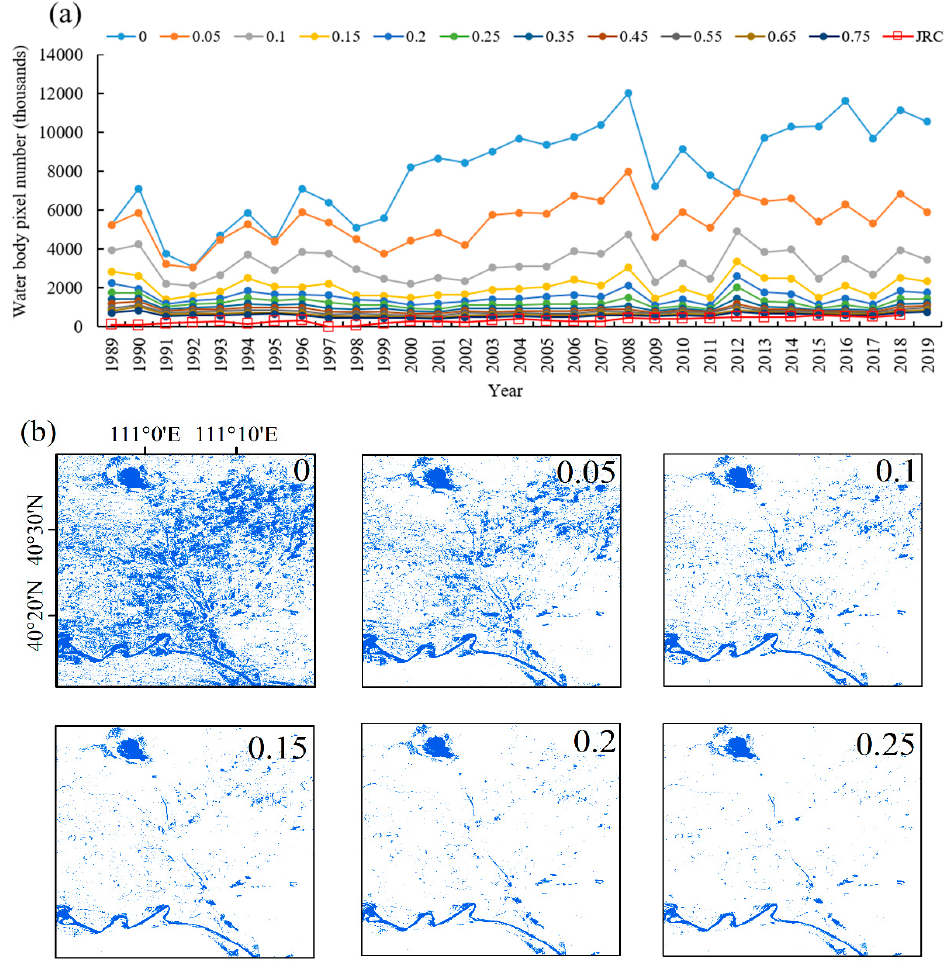
Figure 12. Water body frequency threshold selection; ( a ) The number of water pixels with a frequency > 0, ≥ 0.05, ≥ 0.1, ≥ 0.15, ≥ 0.2, ≥ 0.25, ≥ 0.35, ≥ 0.45, ≥ 0.55, ≥ 0.65, and ≥ 0.75 in the study area from 1989 to 2019, respectively, and the number of permanent water pixels in the Joint Research Center (JRC) dataset; ( b ) Noise conditions of insets in the 2019 maximum water body maps using different water body frequency thresholds: 0, 0.05, 0.1, 0.15, 0.2, and 0.25.